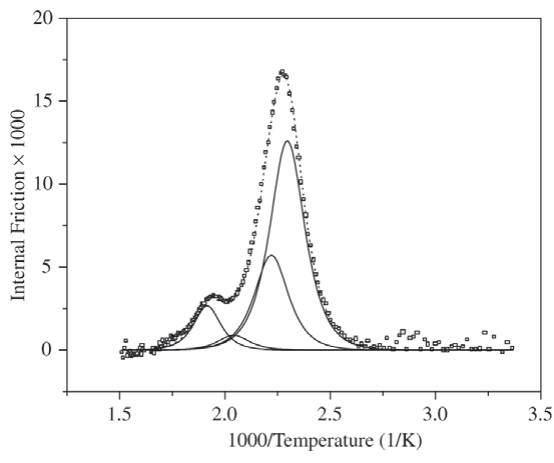
Figure 2. Internal friction as a function of temperature for Nb-0.08Zr-O alloy, resolved into constituent peaks corresponding to the interactions: Nb-O at 434 K, Nb-O-O at 450 K, Nb-O-O-O at 490 K and Zr-O at 517